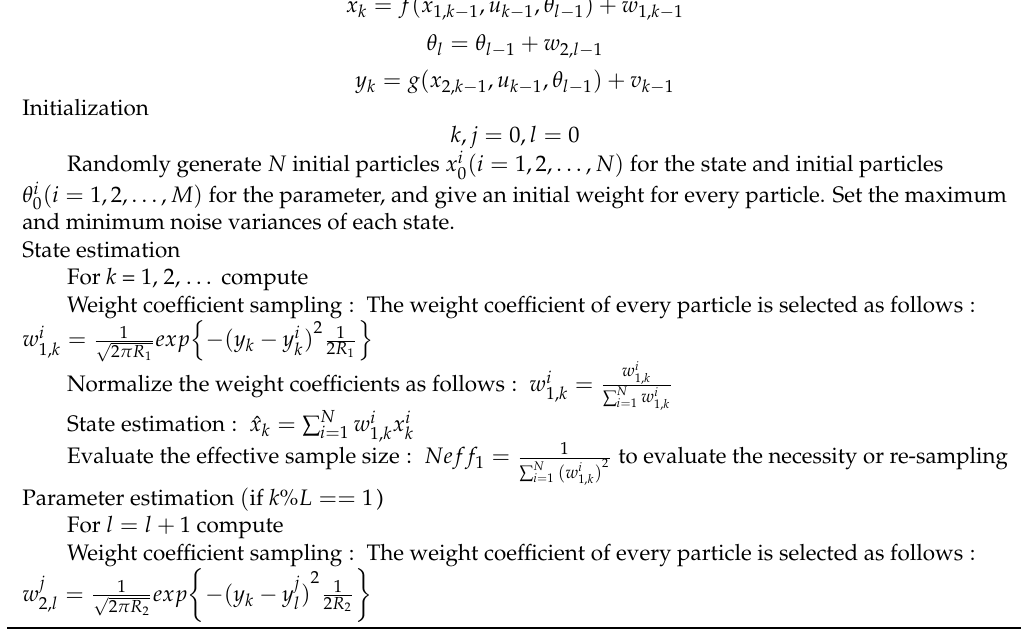
Table 8. Summary of the double-scale dual adaptive particle filter for SOC estimation [107]. Non-linear state-space